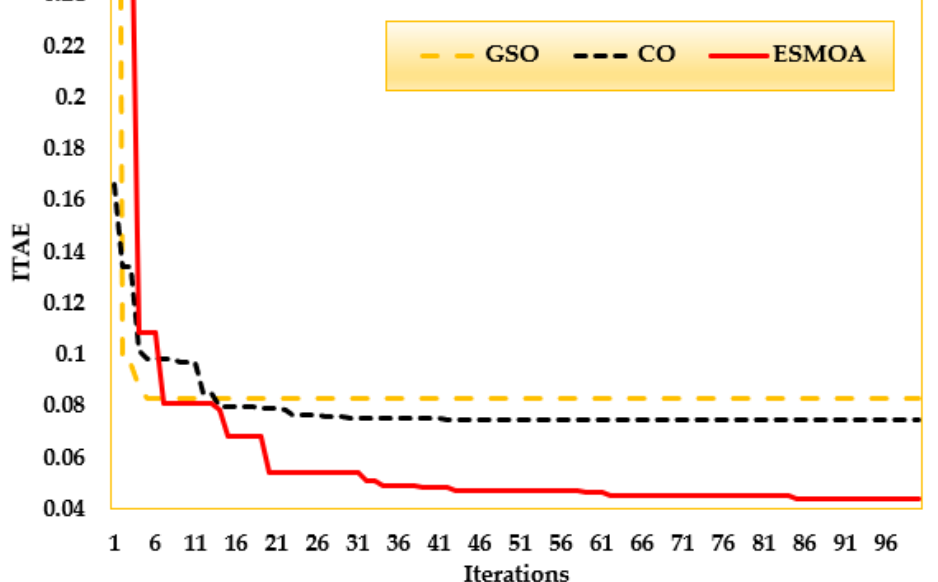
Figure 11. Converging characteristics of the suggested ESMOA, GSO, and CO techniques for Case 3.